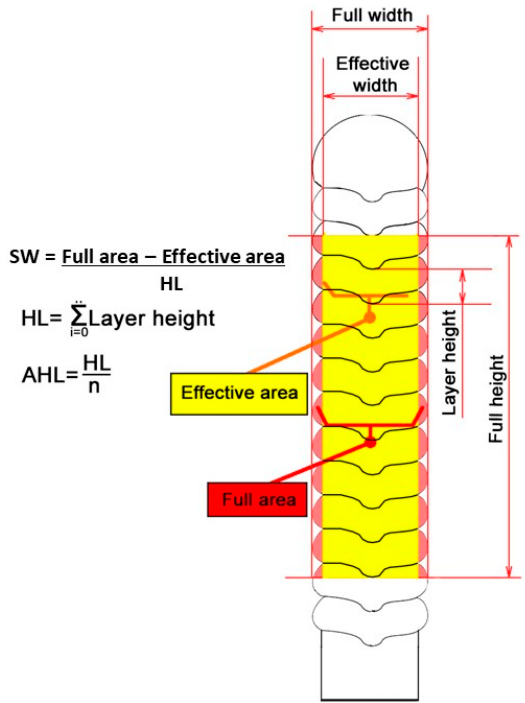
Figure 7. Schematic of a wall cross-sections with the geometric parameters measured to assess the wall geometry quality, where SW is a quality related index, LH is the height of all analyzed layers, ALH is the average height per layer, and “n” the number of the analyzed layers.